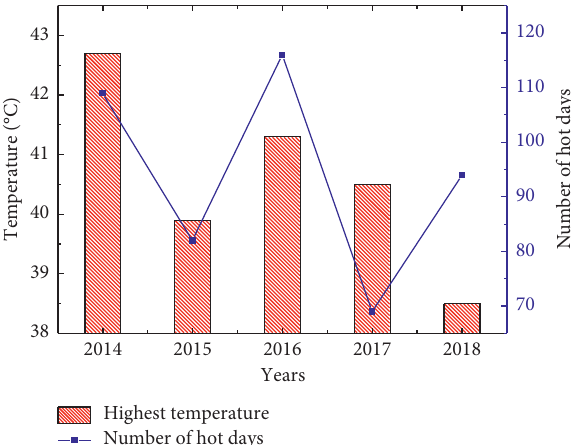
Figure 4: The highest temperature and the number of hot days.